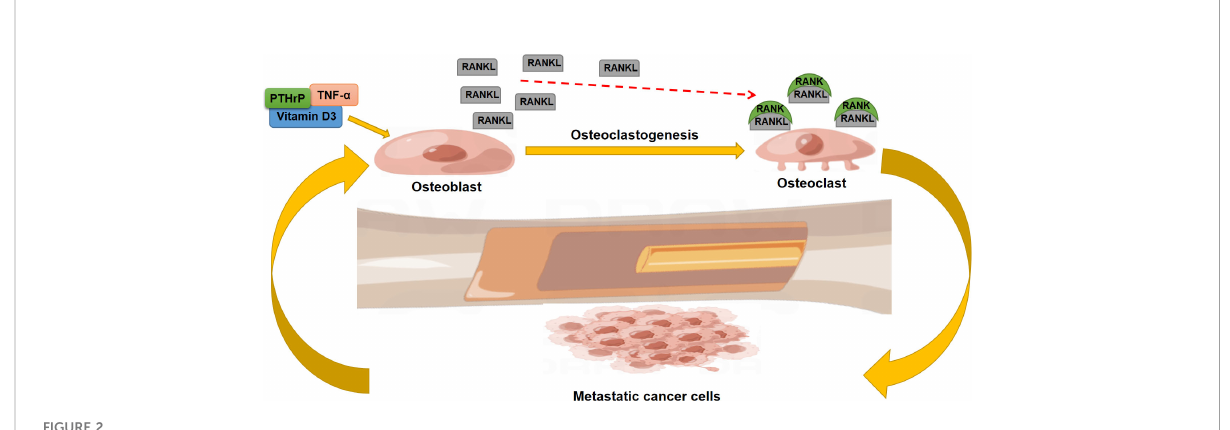
FIGURE 2 The role of the RANK/RANKL axis in the regulation of bone